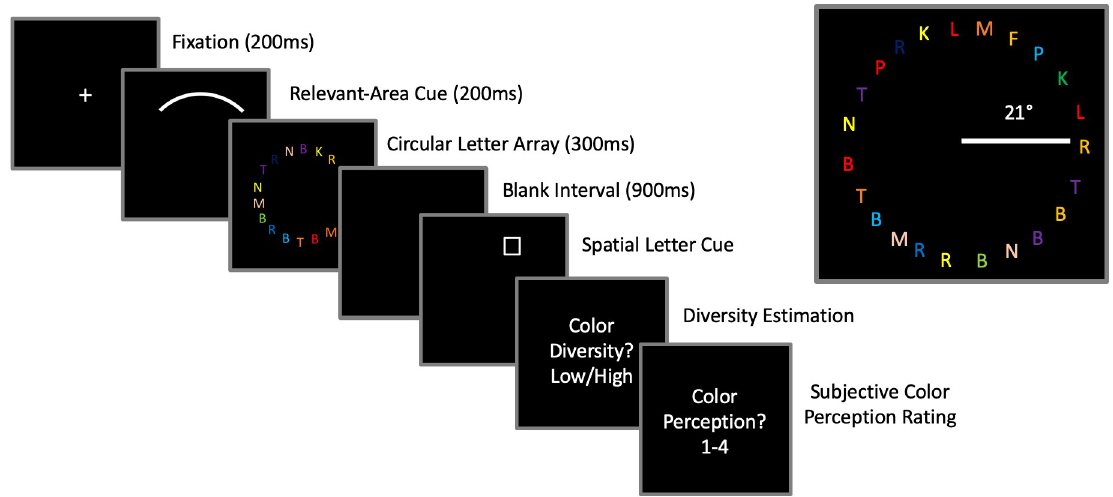
Fig 1. Experiment 1: Testing “cost-free” color perception in peripheral vision. On each trial, following a brief fixation cross, participants received a 200ms cue (a curved white arc) which alerted them to the region of space that they needed to attend to. Following the cue, 24 colored letters appeared in a circular pattern for 300ms in the visual periphery. As shown by the inset, these letters were presented approximately 21 degrees away from fixation on our large projection screen. Following a blank interval of 900ms, participants then answered three questions: The cued letter recall, a judgment of whether the color diversity (in the cued or uncued regions) was either low or high, and their subjective color perception for the same region as the color diversity judgment. On a small proportion of trials, the white fixation cue was accompanied by a letter placed at fixation, and subjects were immediately asked to report the letter identity. These “catch” trials were randomly interleaved throughout the experiment to ensure that subjects were incentivized to always fixate on the cross.